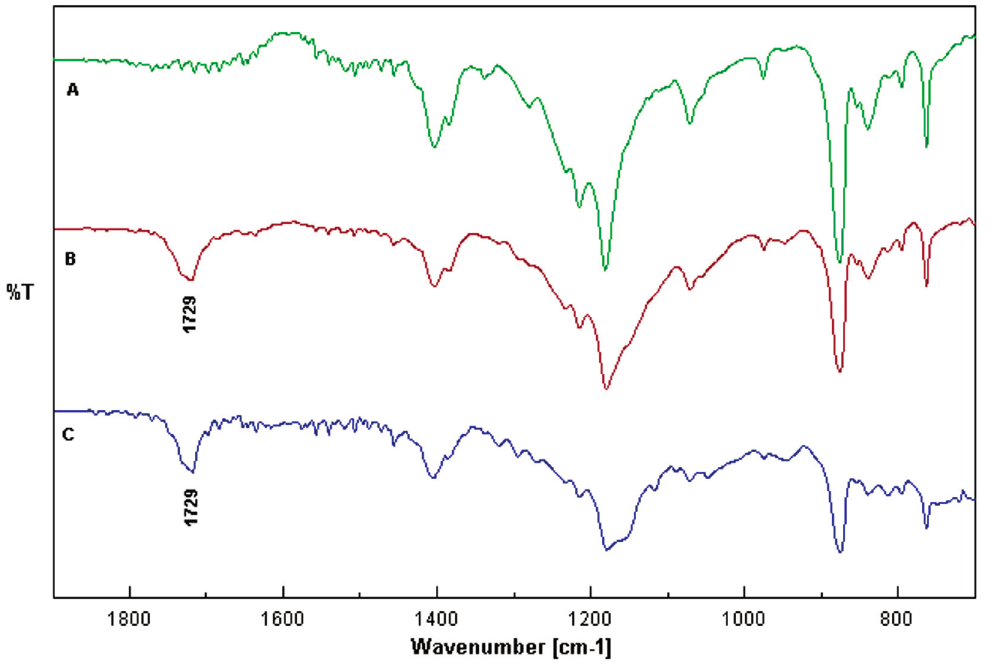
Figure 3. FTIR spectra of a blank PVDF membrane (A), PVDF + NIM (B) and PVDF + MIM